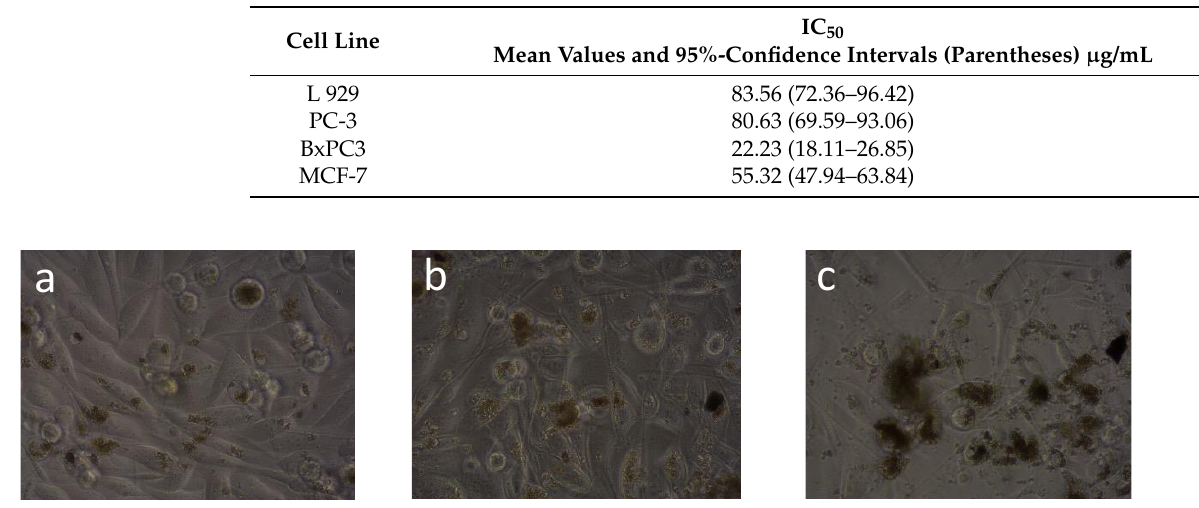
Table 4. Values of IC 50 parameters for different cell lines.